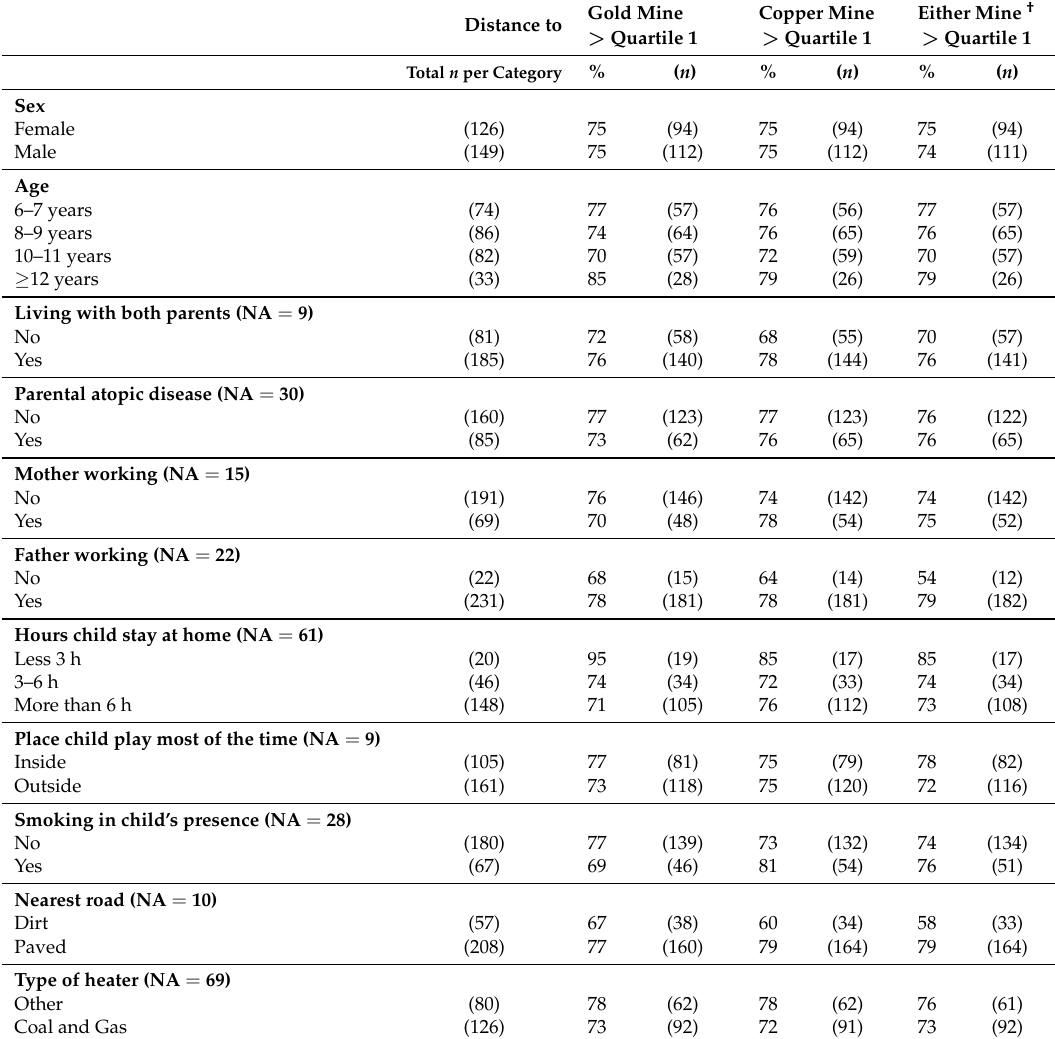
† Indicates distances above the first quartile to either mine; NA: missing